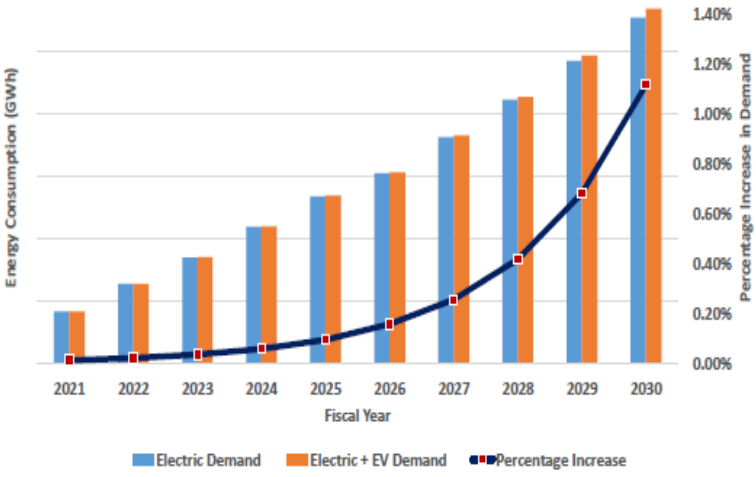
Figure 6. Percentage increase in demand forecast by EVs. The energy consumption of each EV category is shown in Figure